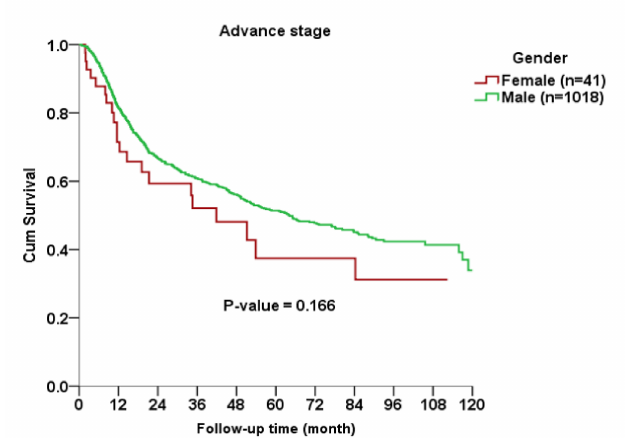
Figure 3. Kaplan–Meier curve for overall survival rates between female and male patients with advanced-stage oral squamous cell